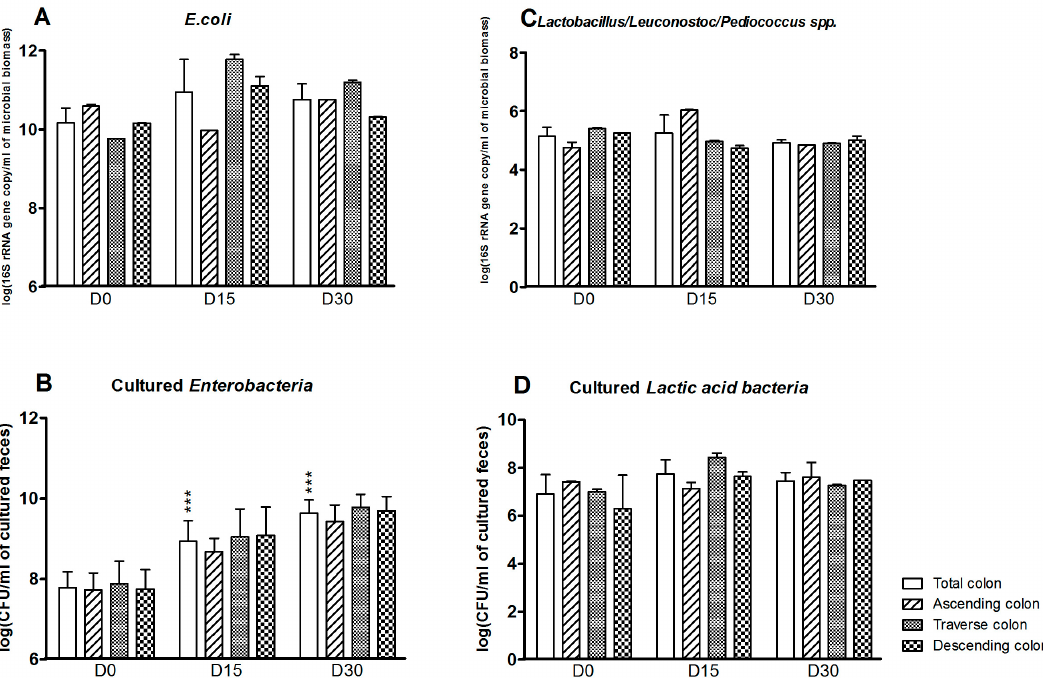
Figure 3. Aerobe counts for the SHIME ® ’s colon as a whole and for each of the individual colon reactors at the end of the control period (D0) and after 15 and 30 days of exposure to CPF 1 mg/day in oil (D15 and D30). ( A ) E. coli counts determined by qPCR (log 16S rRNA gene copy/mL of microbioal biomass); ( B ) Cultured enterobacterial counts (log CFU/mL of cultured feces); ( C ) Lactobacillus/Leuconostoc/Pediococcus counts determined by qPCR (log 16S rRNA gene copy/mL of microbioal biomass); ( D ) Cultured LAB counts (log CFU/mL of cultured feces). Data are expressed as the mean ± SD and were analyzed in a Kruskal Wallis test and then a Mann Whitney test. The level of statistical significance is indicated as follows: *** p < 0.001.